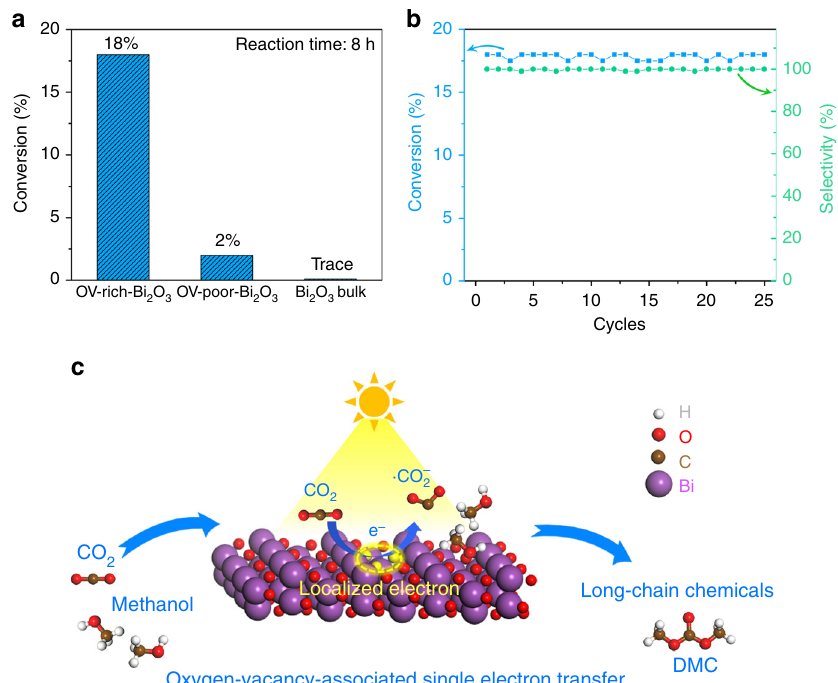
Fig. 5 Catalytic performances and schematic reaction processes. a Performances of various catalysts for CO 2 fi xation at 373 K under Xe-lamp irradiation. b Photostability cyclic test for OV-rich-Bi 2 O 3 nanosheets. Reaction time for each run: 8 h. c Schematic introduction for the photo fi xation of CO 2 to long- chain chemicals